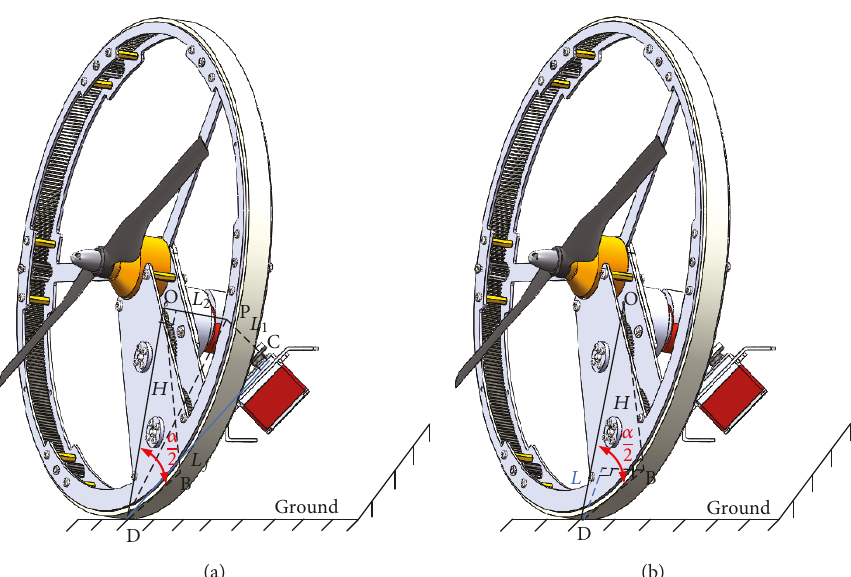
Figure 10: The geometric relationship analysis of a certain angle in the transformable process.